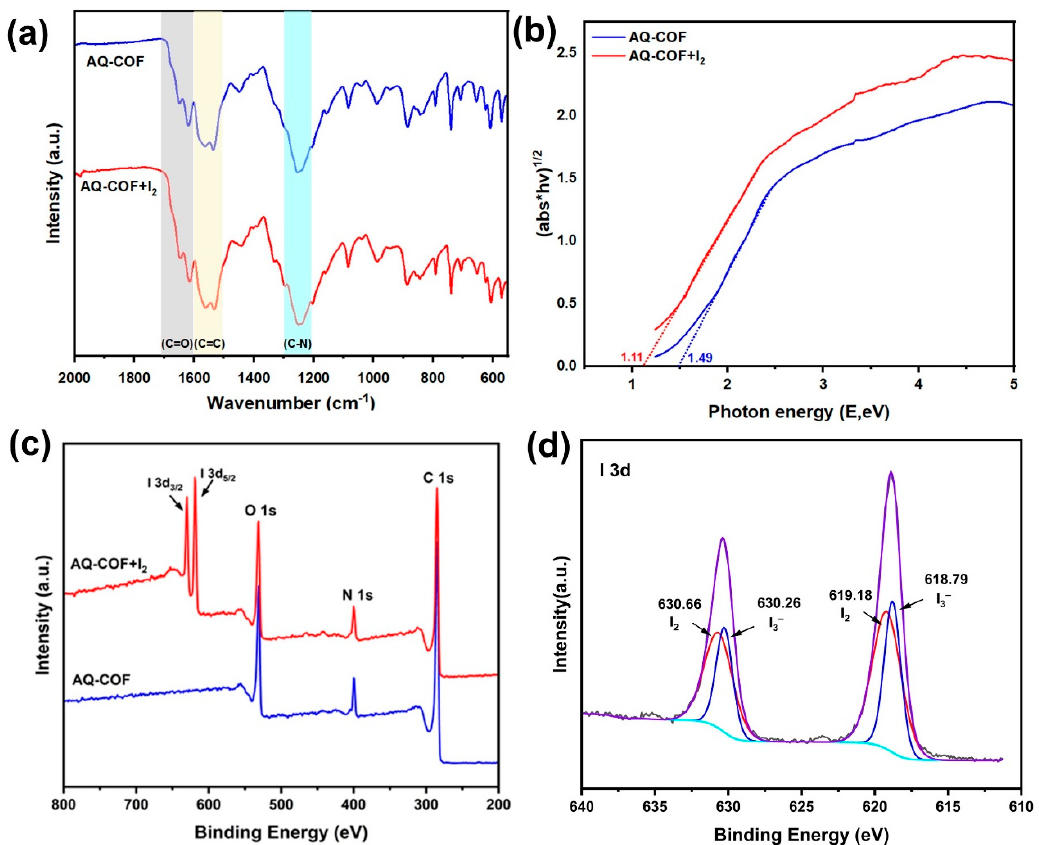
Figure 5. ( a ) FT-IR spectra of AQ-COF and I 2 vapor adsorbed AQ-COF. It contains C=O (grey), C=C (yellow) and C-N (blue) bands of vibration. ( b ) The optical band gap of AQ-COF and I 2 vapor adsorbed AQ-COF, ( c ) XPS survey spectra of AQ-COF and I 2 vapor adsorbed AQ-COF, and ( d ) XPS spectra of I 2 vapor adsorbed AQ-COF .